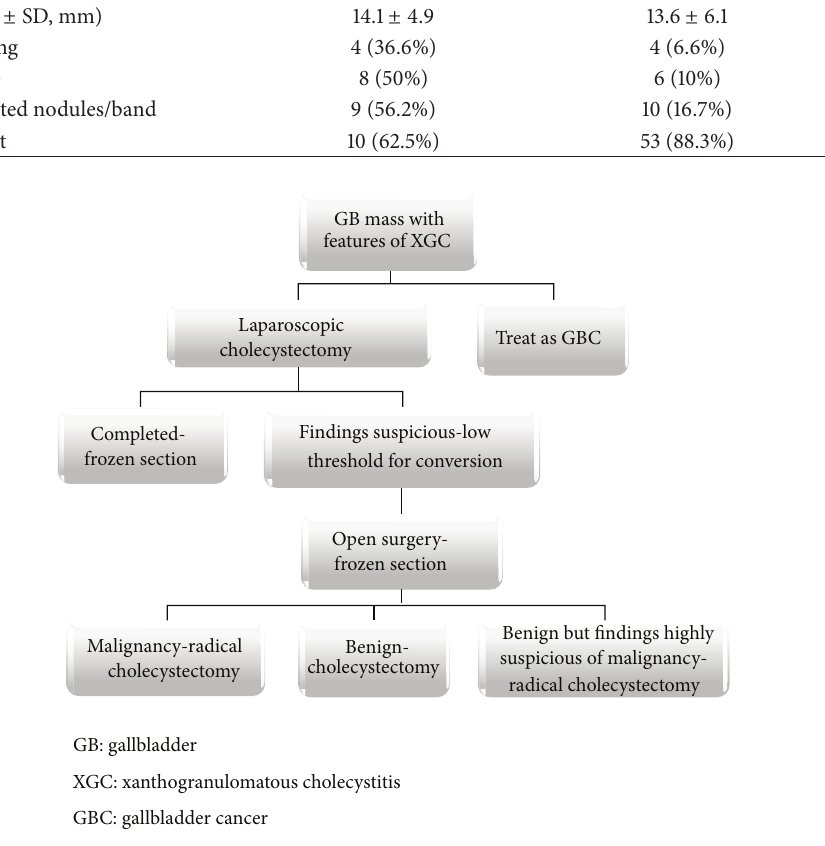
Figure 4: Algorithm for management of gallbladder mass with features of